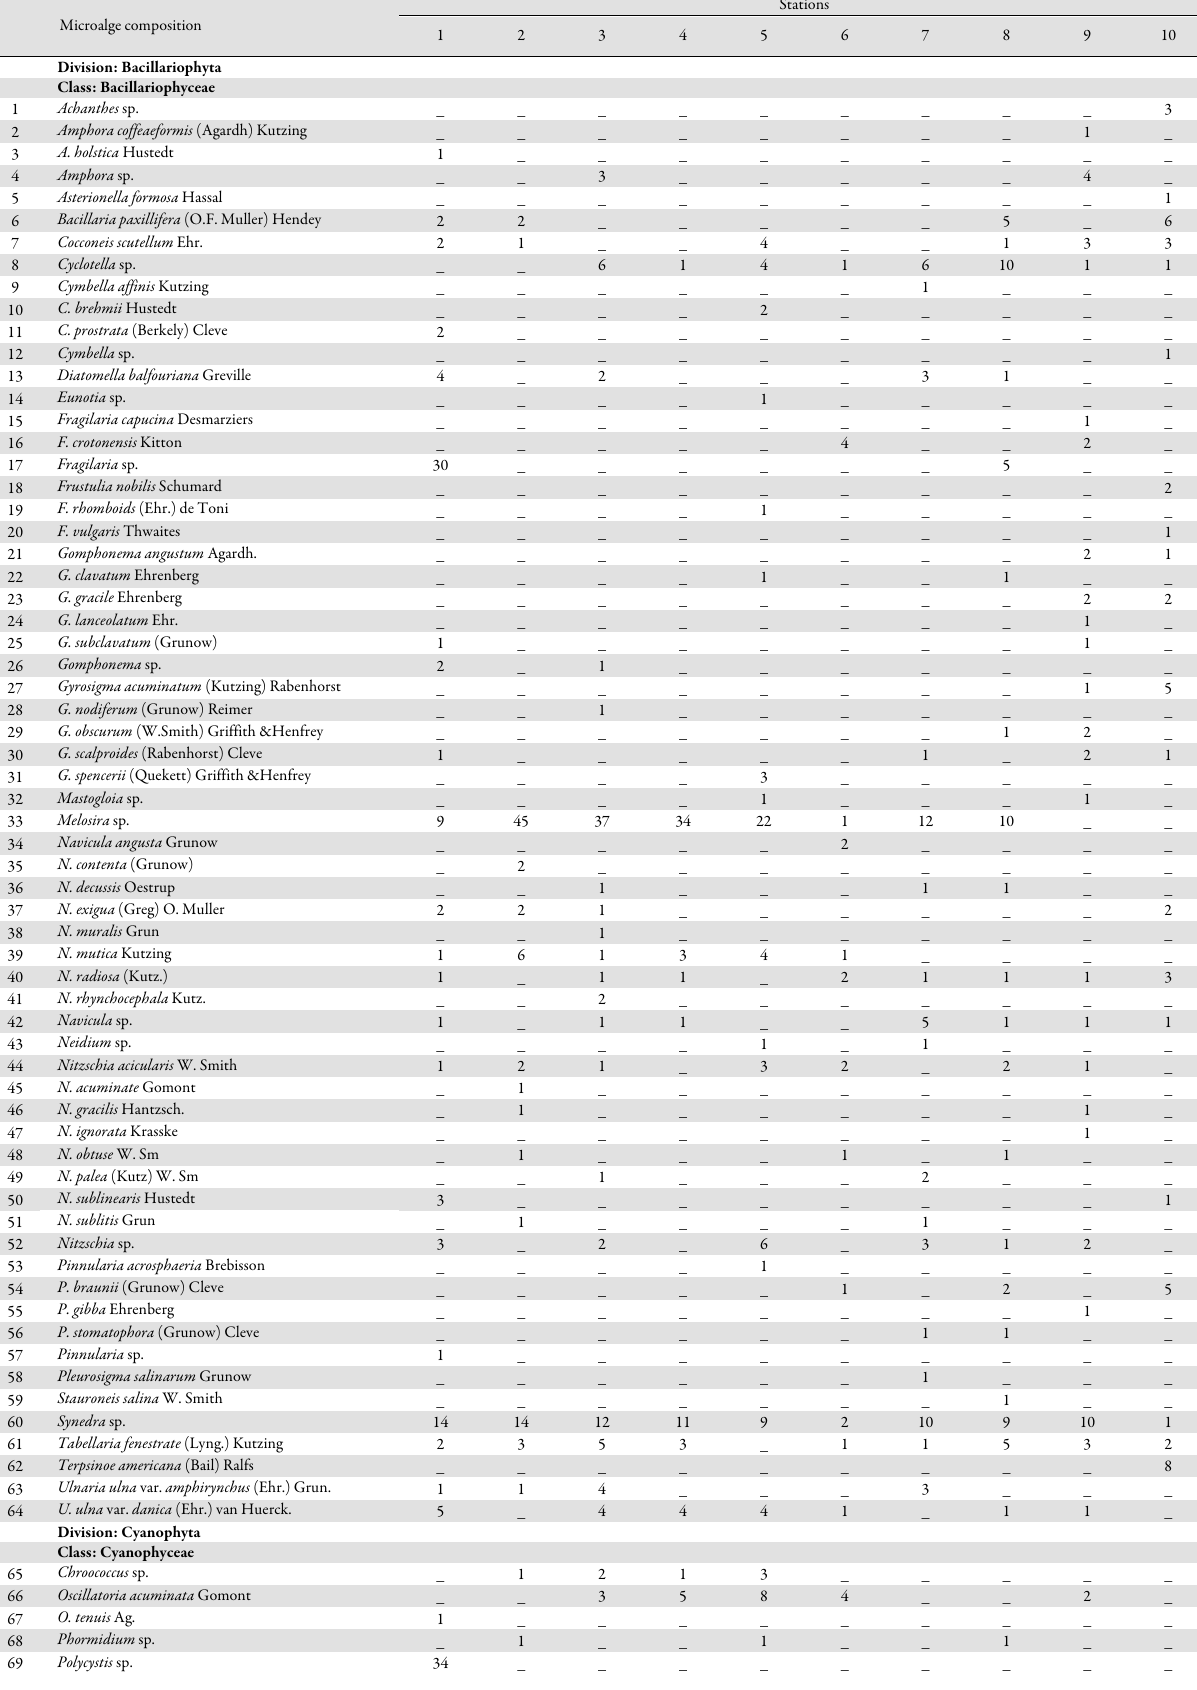
Table 3. Microalgae composition and abundance (cells/mL) at Ibefun River (Ogun state) Microalge composition Division: Bacillariophyta Class: